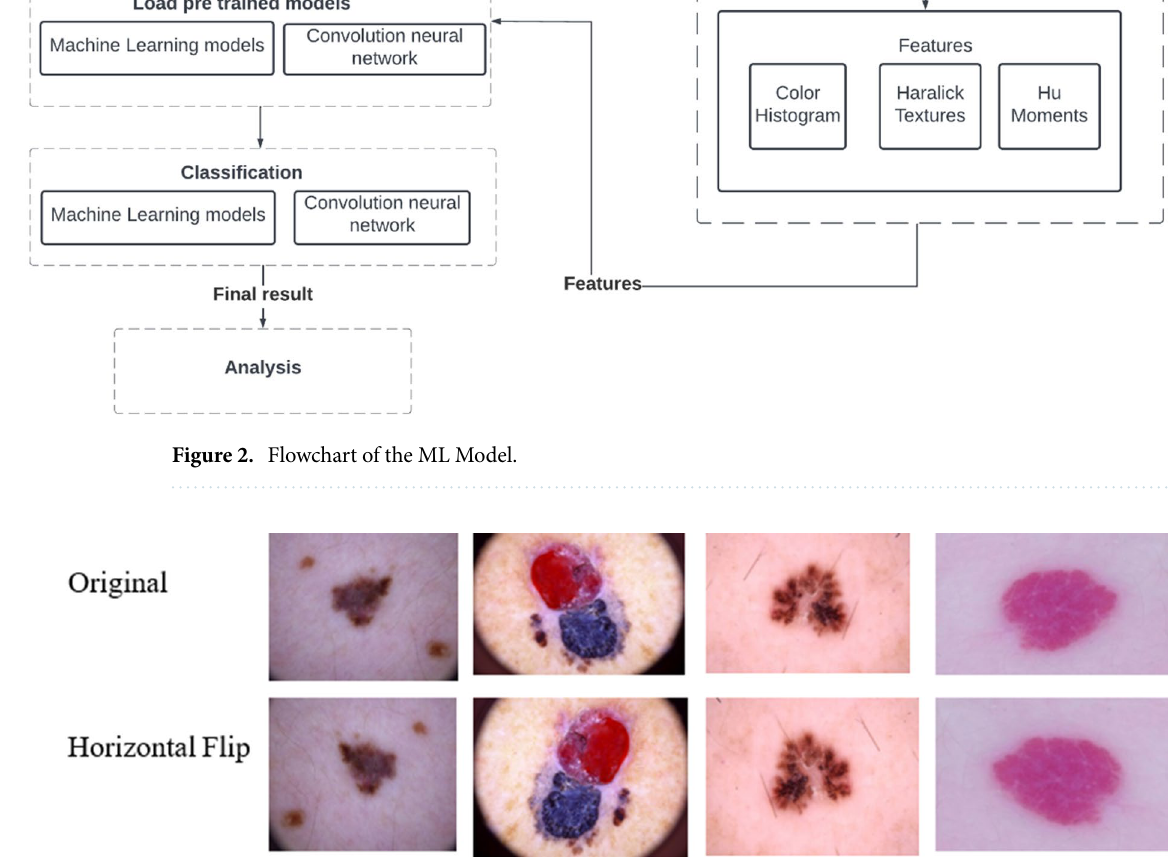
Figure 3. Horizontal Flip